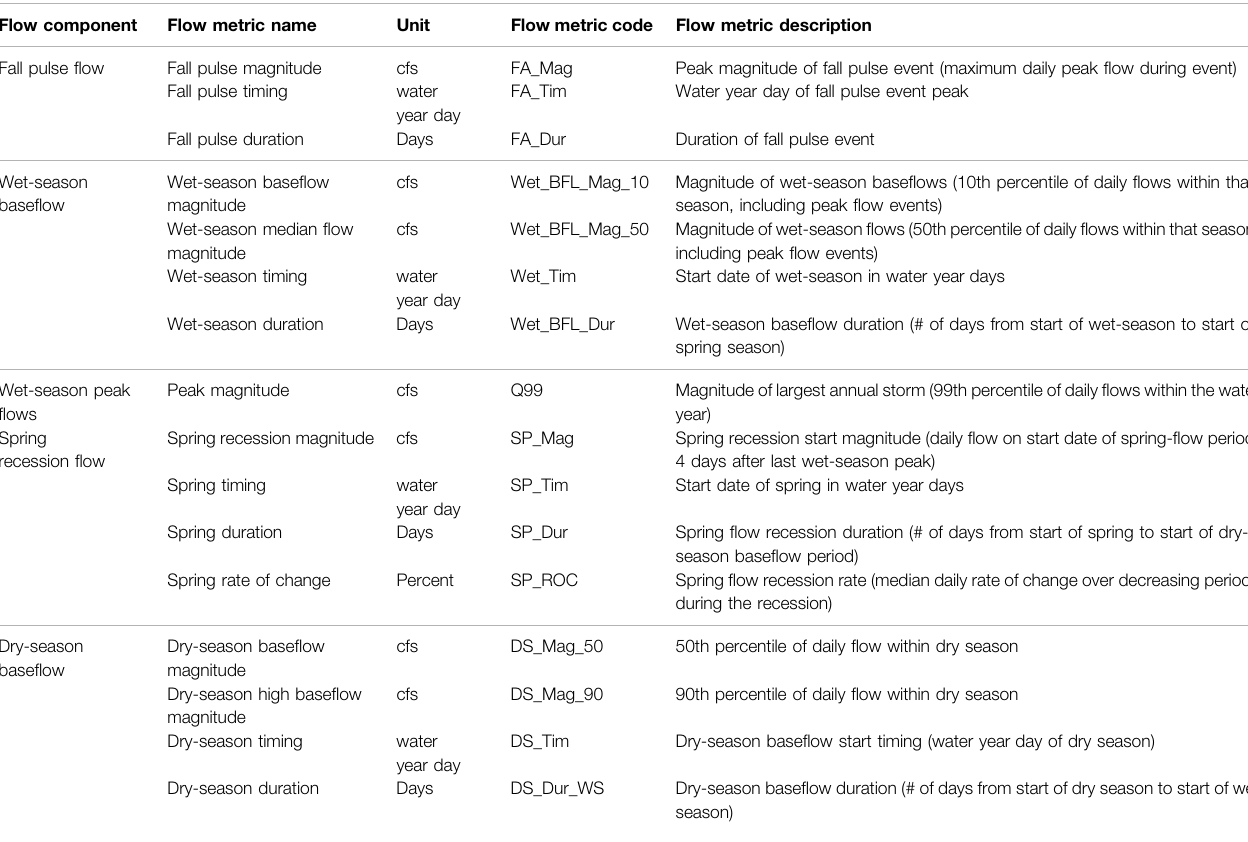
TABLE 1 | Initial Functional Flow Metrics ( n (cid:1) 16) used in this study, modi fi ed from Yarnell et al. (2020). With their associated fl ow components ( n (cid:1) 5), codes, descriptions, and